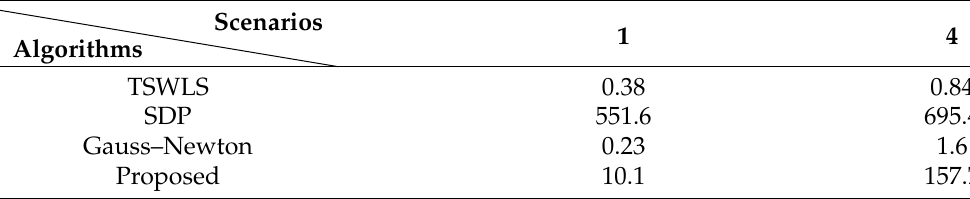
Table 1. Avg. CPU time [ms] for